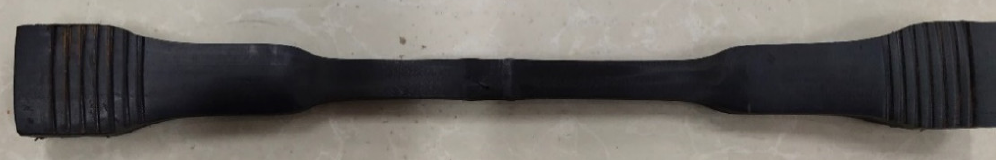
Figure 5. Distribution of hardness in the butt fusion joint of the HDPE: ( a ) hardness in the axial direction, ( b ) hardness along the wall thickness.